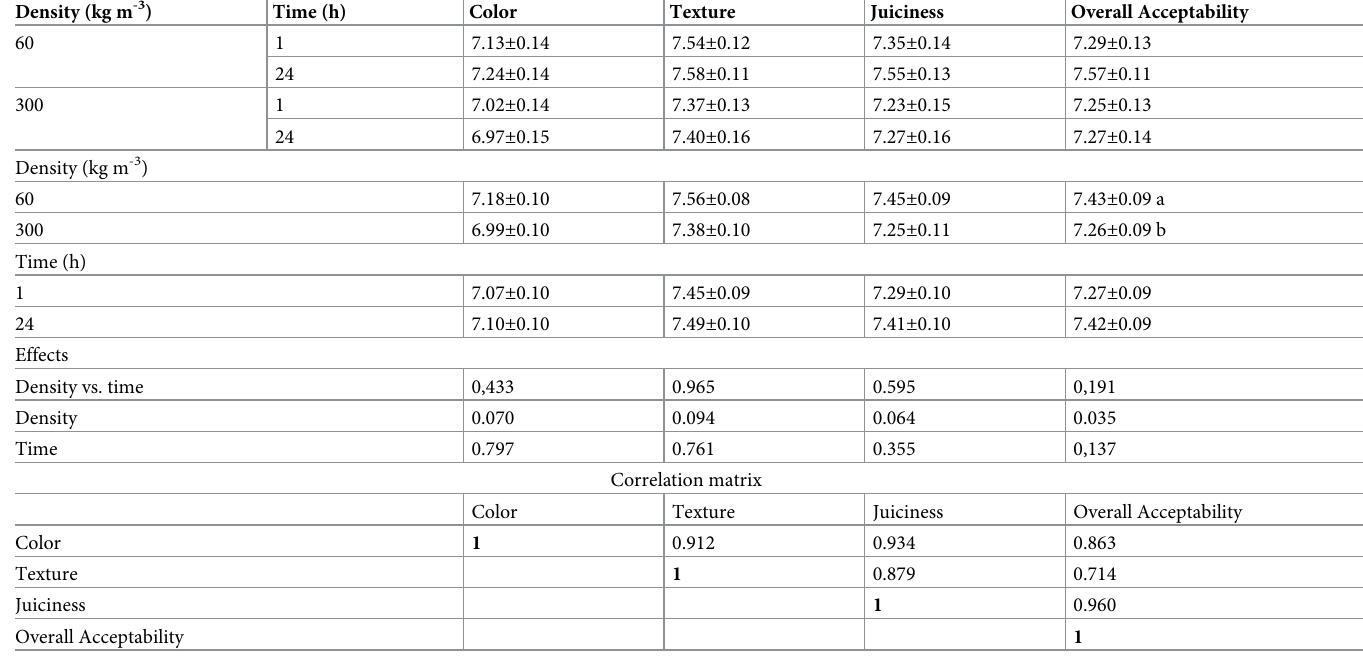
Hedonic scale between 1 (disliked extremely) and 9 (liked extremely); Data are expressed as the mean ± standard error of the